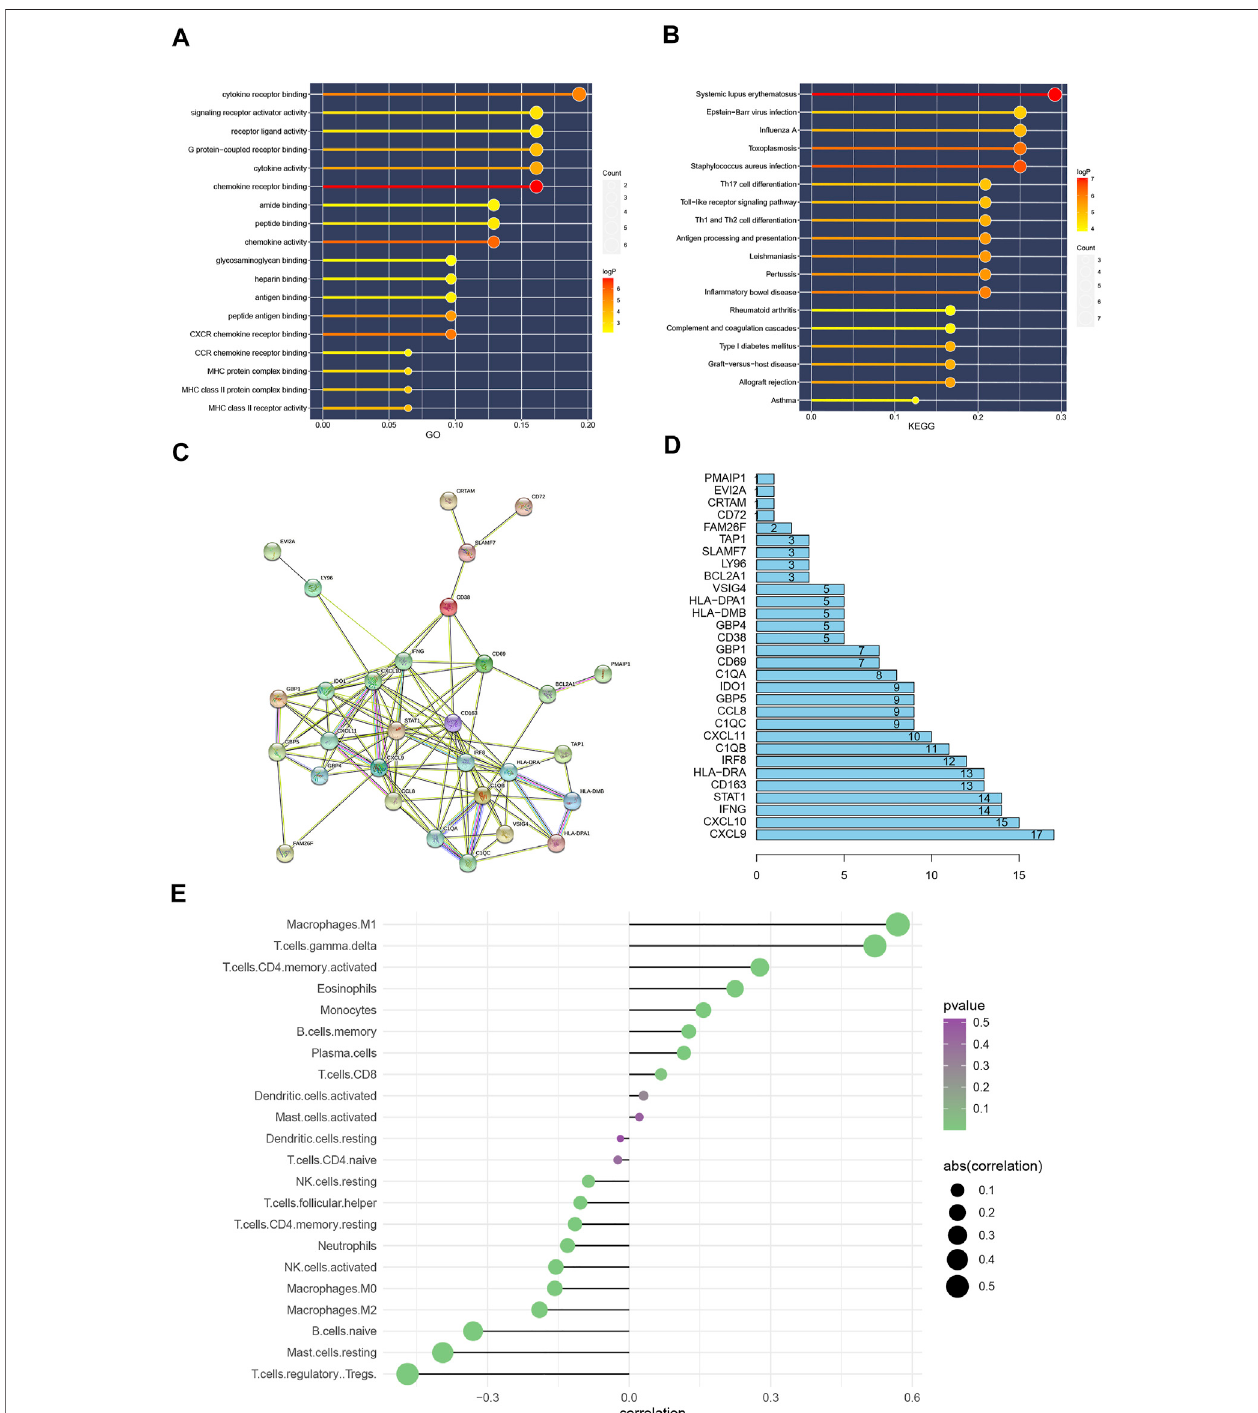
FIGURE 3 | (A) : GO function enrichment analysis results. (B) : KEGG function enrichment analysis results. The color of the bar graph represents the p value, The color change from light todark means that the p value becomeslarger gradually,and the sizeof theendpointsrepresents thenumber ofgenesenriched in the pathway, the larger the endpoints the greater the number of enriched genes. (C) : Protein interaction network, Protein interaction network results. (D) : Statistics of the number of protein interactions, (E) : The result of immune cell in fi ltration. The value of the abscissa represents the correlation between the in fi ltration of immune cells and the occurrence of BPAR. The color change from green to purple represents the gradual increase of p value, and the size of the bar graph represents the size of correlation with BPAR. Correlation > 0 represents immune cells positively correlated with BPAR, and correlation < 0 and immune cells negatively correlated with BPAR.